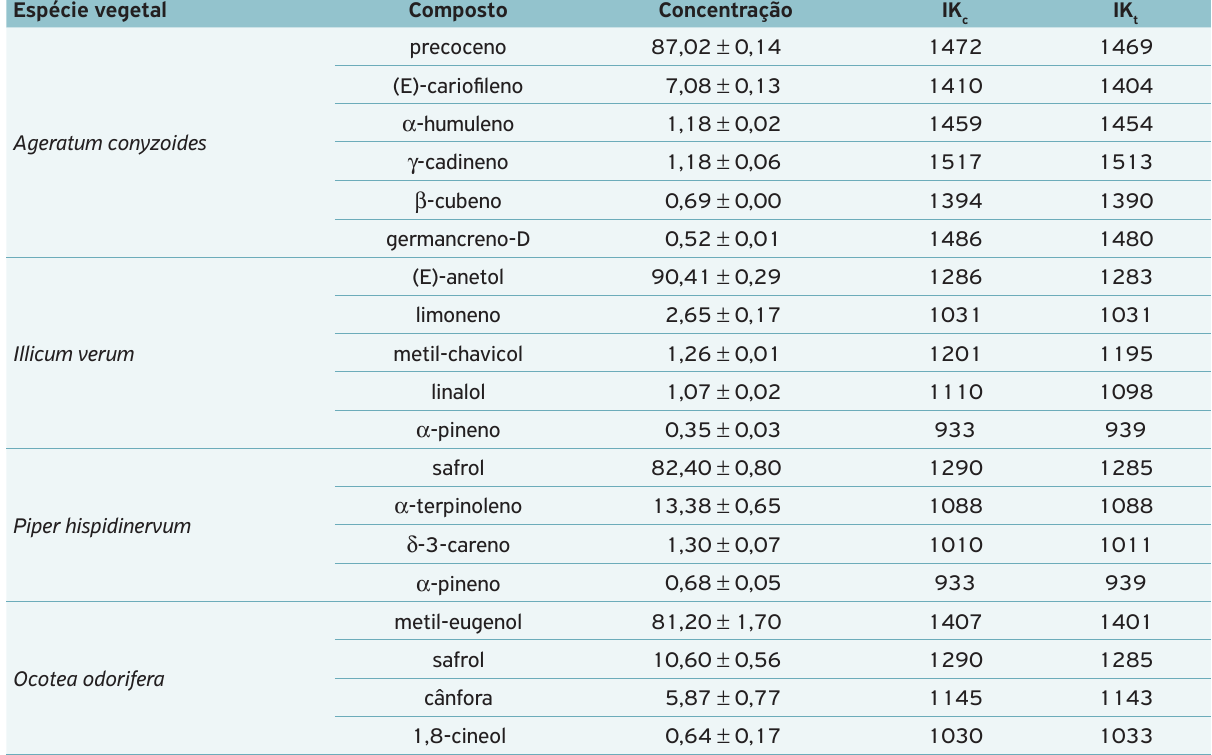
) (baseados nos tempos de retenção c